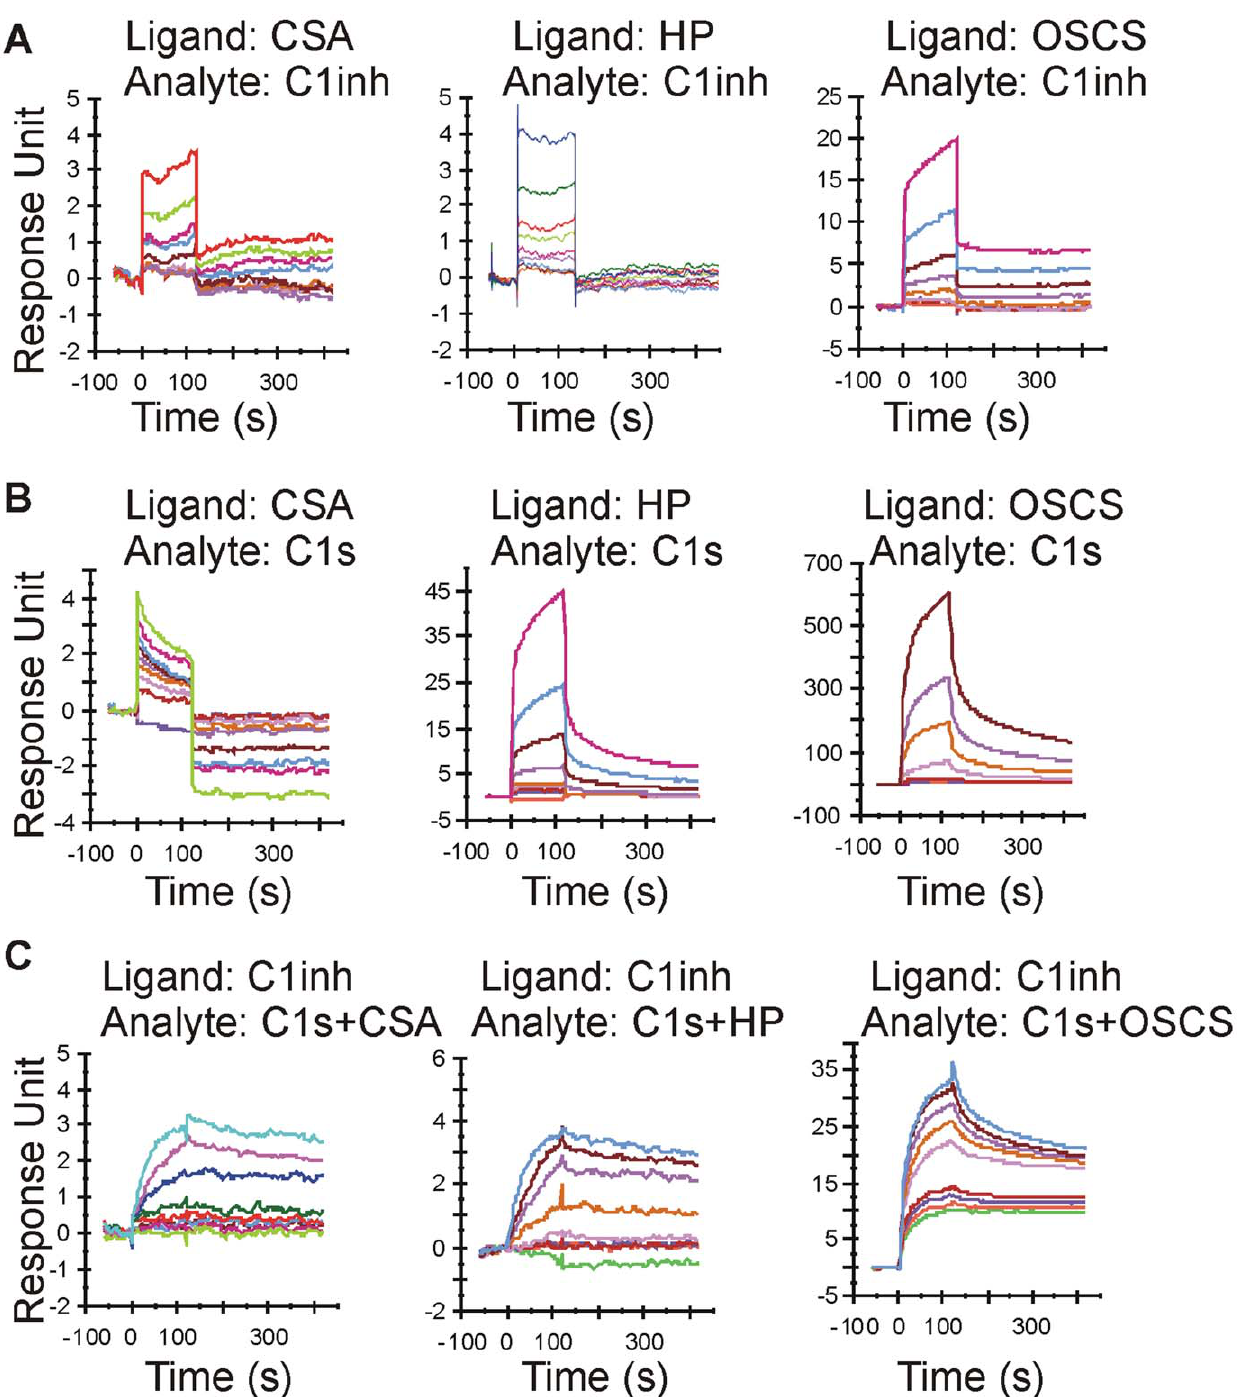
Figure 5. OSCS potentiates the binding of C1inh to C1s. The biotin-labeled GAGs, CSA, heparin and OSCS, were immobilized on NeutrAvidin- immobilized CM5 sensor chips as described in Materials and Methods. Biacore sensorgrams are shown for different analyte concentrations (from top 500, 250, 125, 62.5, 31.25, 15.6, 7.8, 3.9 and 1.95 nM) of (A) C1inh or (B) C1s binding to the immobilized GAG surfaces (ligands). The surfaces for the immobilized GAGs were regenerated each cycle using 2 M NaCl. (C) Biotin-labeled goat anti-human C1inh polyclonal antibody was immobilized on a streptavidin sensor chip and 1 m M of C1inh was injected to create a C1inh surface. Different concentrations of C1s (from top 1000, 500, 250, 125, 62.5, 31.25, 15.6, 7.8 and 3.9 nM) were then injected in the presence of 200 nM CSA, heparin or OSCS and the resulting sensorgrams are shown. The binding of GAGs (i.e., at 0 nM of C1s) with the C1inh surface were subtracted from the sensorgrams during data analysis. The C1inh surface was regenerated each cycle by injecting 30 m l/min pH 3.0 glycine for 30 seconds. Data are rep resentative of three independent experiments.